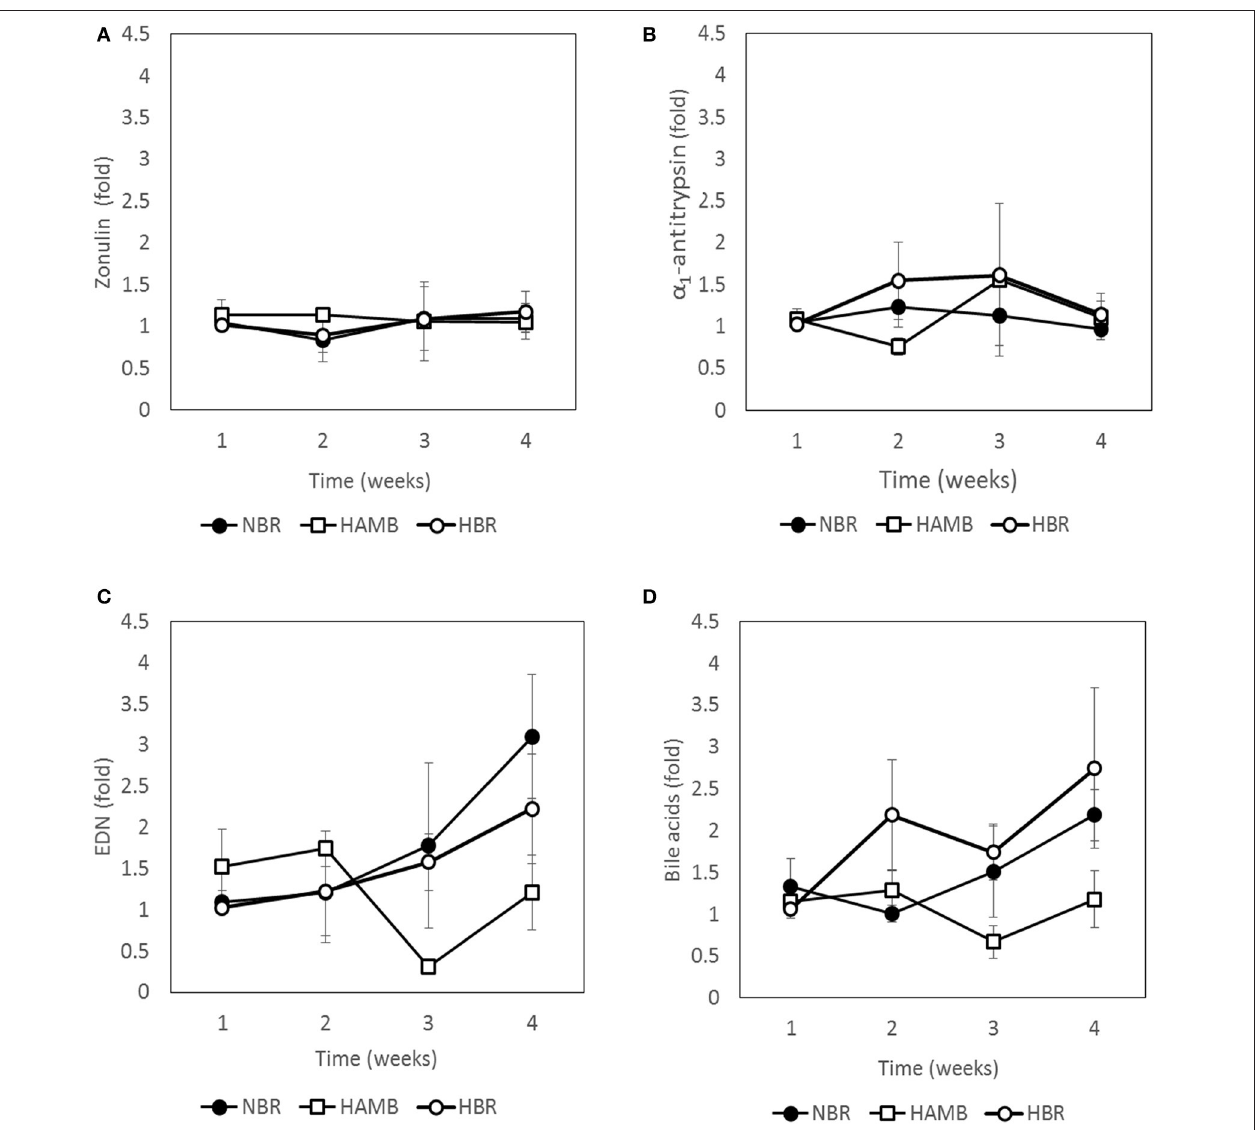
FIGURE 2 | Changes in immunological markers present in fecal samples: zonulin (A), α 1 -antitrypsin (B) , eosinophil-derived neurotoxin (EDN) (C) and bile acids (D) during run-in (week 1) and subsequent 3-week experimental